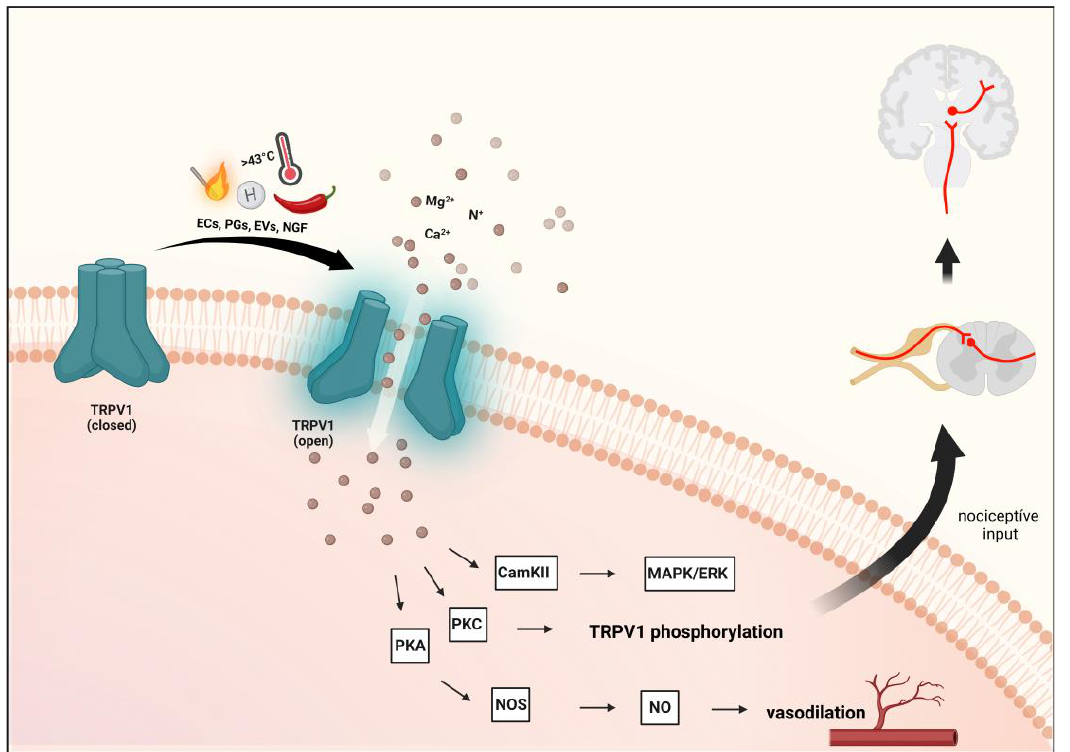
Figure 3. Transient receptor potential vanilloid 1 receptor activation. Activation of TRPV1 and the resulting influx of cations can further activate voltage-gated ion channels to generate action potentials to be required for pain or itch signaling. Several inflammatory mediators lower the activation threshold of TRPV1 via phosphorylation mainly through the activation of the cAMP-dependent protein kinase A (PKA) pathway. Furthermore, protein kinase C (PKC)-dependent cascade is also involved. TRPV1: transient receptor potential vanilloid 1 receptor, ECs: endocannabinoids, EVs: endovanilloids, PGs: prostaglandins, NGF: nerve growth factor. Upon activation of TRPV1, CGRP and SP are released, causing vasodilation